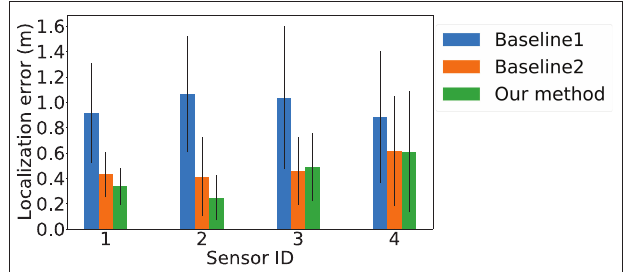
FIGURE 8 | Vision-based footfall event detection parameter motionTh and its impact on localization error. Blue, orange, green, and red bars represent Sensor 1, Sensor 2, Sensor 3, and Sensor 4’s localization error, respectively. The error bars depict standard deviation values.